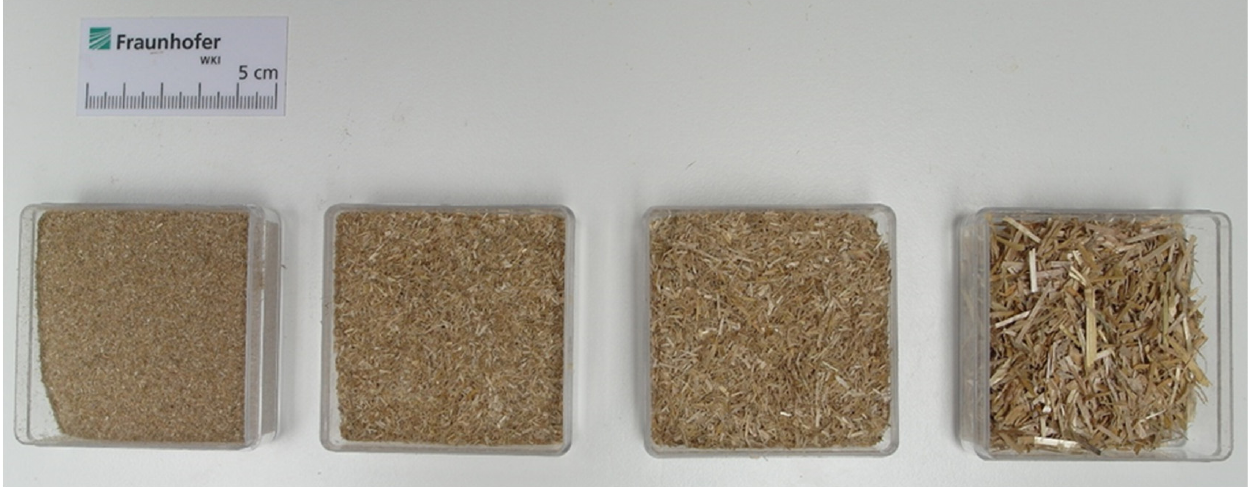
Figure 2. Particle size fractions after sieving. From left to right: 0.6–1.25 mm; 1.25–3.15 mm; 3.15–5 mm; >5 mm. Fraction < 0.6 mm not shown.